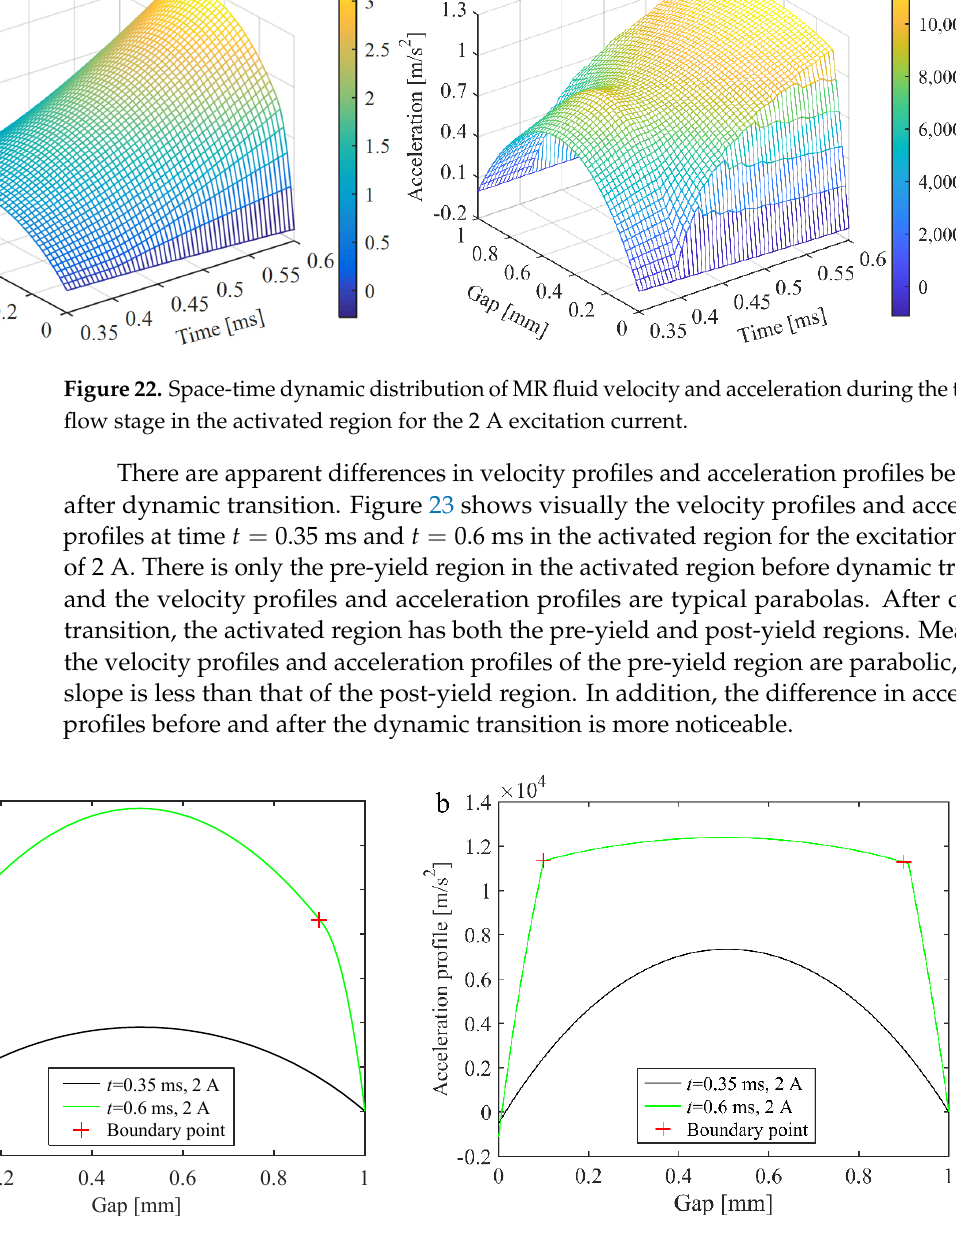
Figure 23. Velocity profiles and acceleration profiles at time t = 0.35 ms and t = 0.6 ms in the activated region for the excitation current of 2